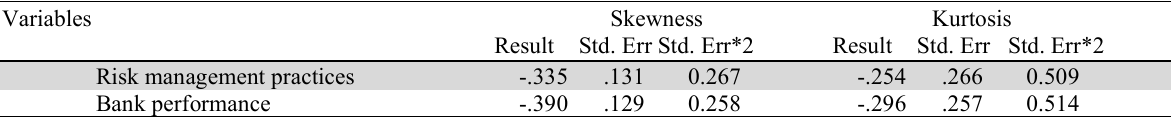
Skewness and Kurtosis Test